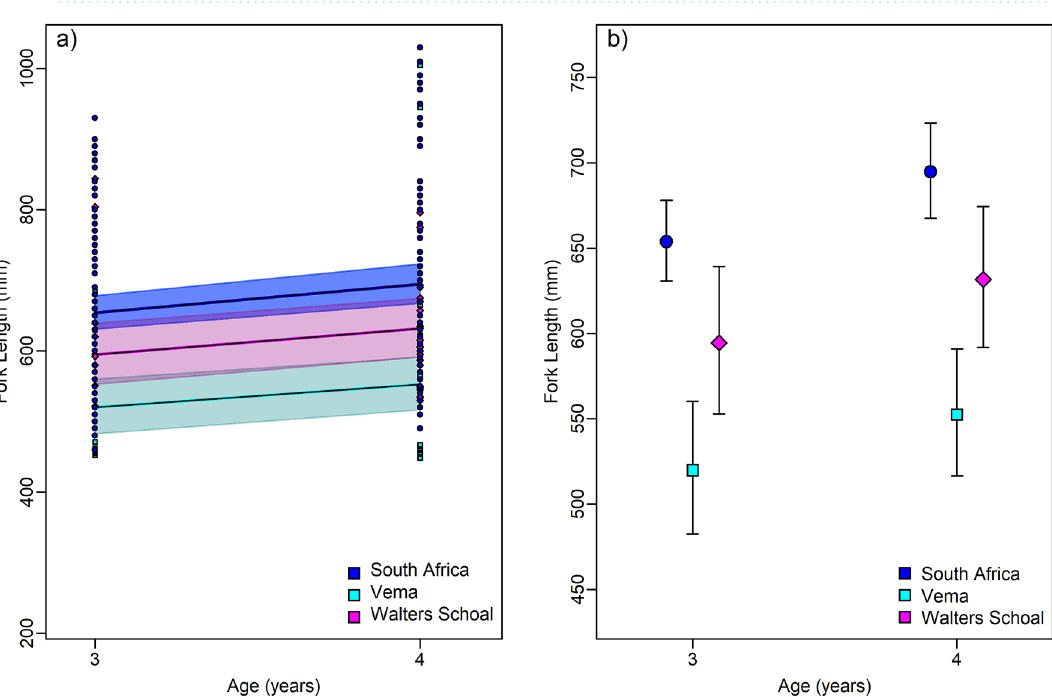
Figure 4. ( a ) Observed (symbols) and predicted (solid lines) lengths-at-age of Age-3 and Age-4 yellowtail from South Africa, Vema and Walters Shoal sampling localities. Coloured coded translucent areas ( a ) and error bars ( b ) denote the 95% confidence intervals the respective sampling locality. Difference in the gradients shades ( a ) result from overlaps in 95% confidence areas. Differences in the colour gradients of shaded areas ( a ) result from overlaps in 95% confidence